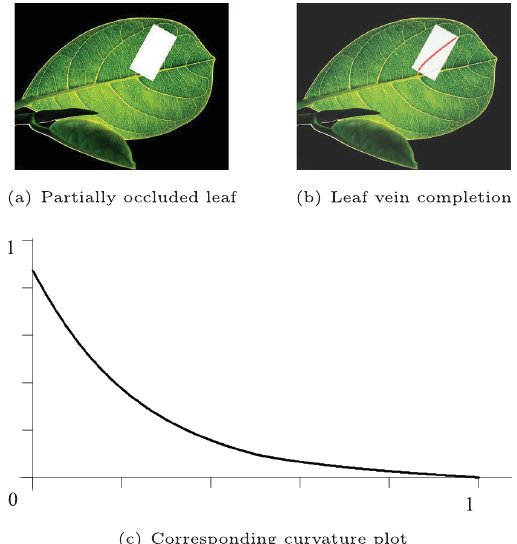
Fig. 12 Leaf vein completion using Algorithm 2.